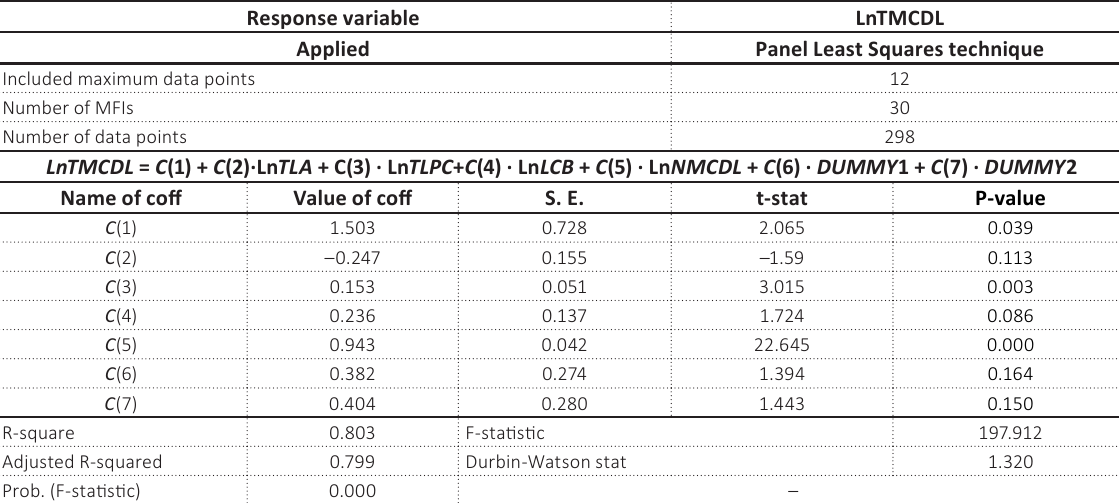
Table 5. Outcomes of the FE model or least square dummy variable